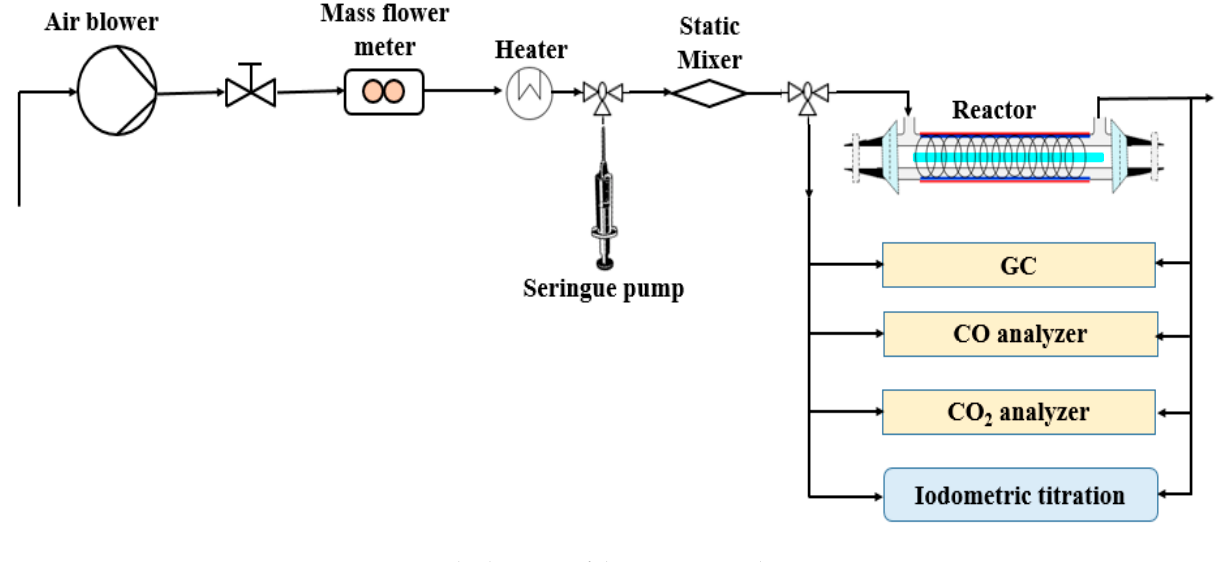
( b ) Figure 7. ( a ) Schematic of the reactor setup and ( b ) cross-section of the concentric cylindrical Pyrex glass tube reactor. 3.2. Gas Phase Analysis The CB concentration, before and after mineralization experiments, was quantified using a gas chromatograph (GC, Thermo Focus, Carlsbad, CA, USA) equipped with a 60 m × 0.25 mm polar DB-MS capillary column (film thickness: 0.25 mm). The GC operating conditions were: flame ionization detector (FID), carrier gas at a flow rate: 1 mL/min − 1 , injector and detector temperature is: 250°C. Samples were collected at the reactor down- stream using a 500 µL gas-tight syringe and manually injected into the GC. The CO 2 concentration was quantified using a multi-gas infrared analyzer equipped with GFC (Gas Filters Correlation) technology (MIR 9000 Environment SA). O 3